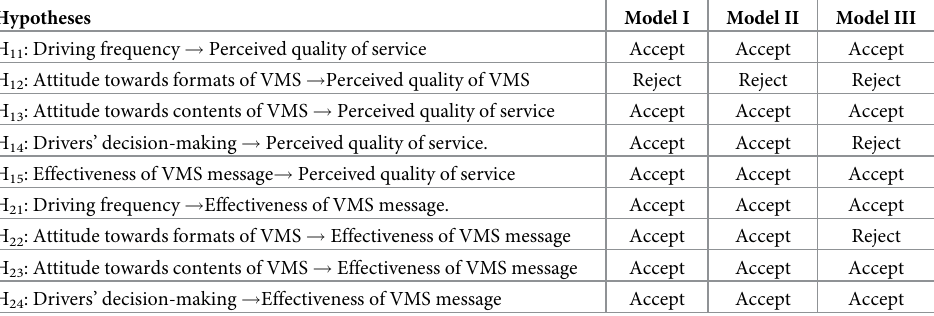
Table 6. Results of hypothesis